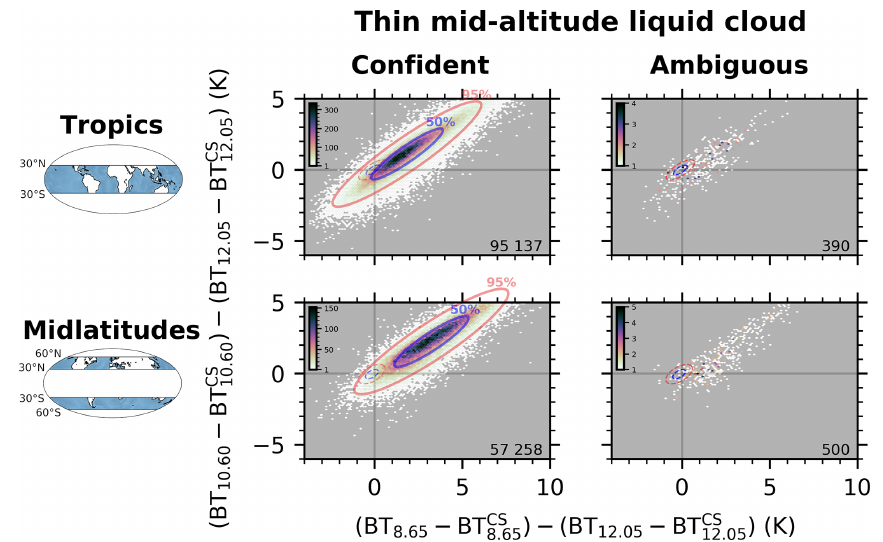
Figure C1. As Fig. 6 for liquid cloud monolayer observations with 0 . 6 < τ < 1 . 5 and 4km < z top < 8km. The solid red and blue ellipses represent the 95% and 50% confidence intervals of the 2-D Gaussian PDF estimated from the confident observations of this specific z top – τ grid and used in the IIR CAD score definition (Eq. 1).